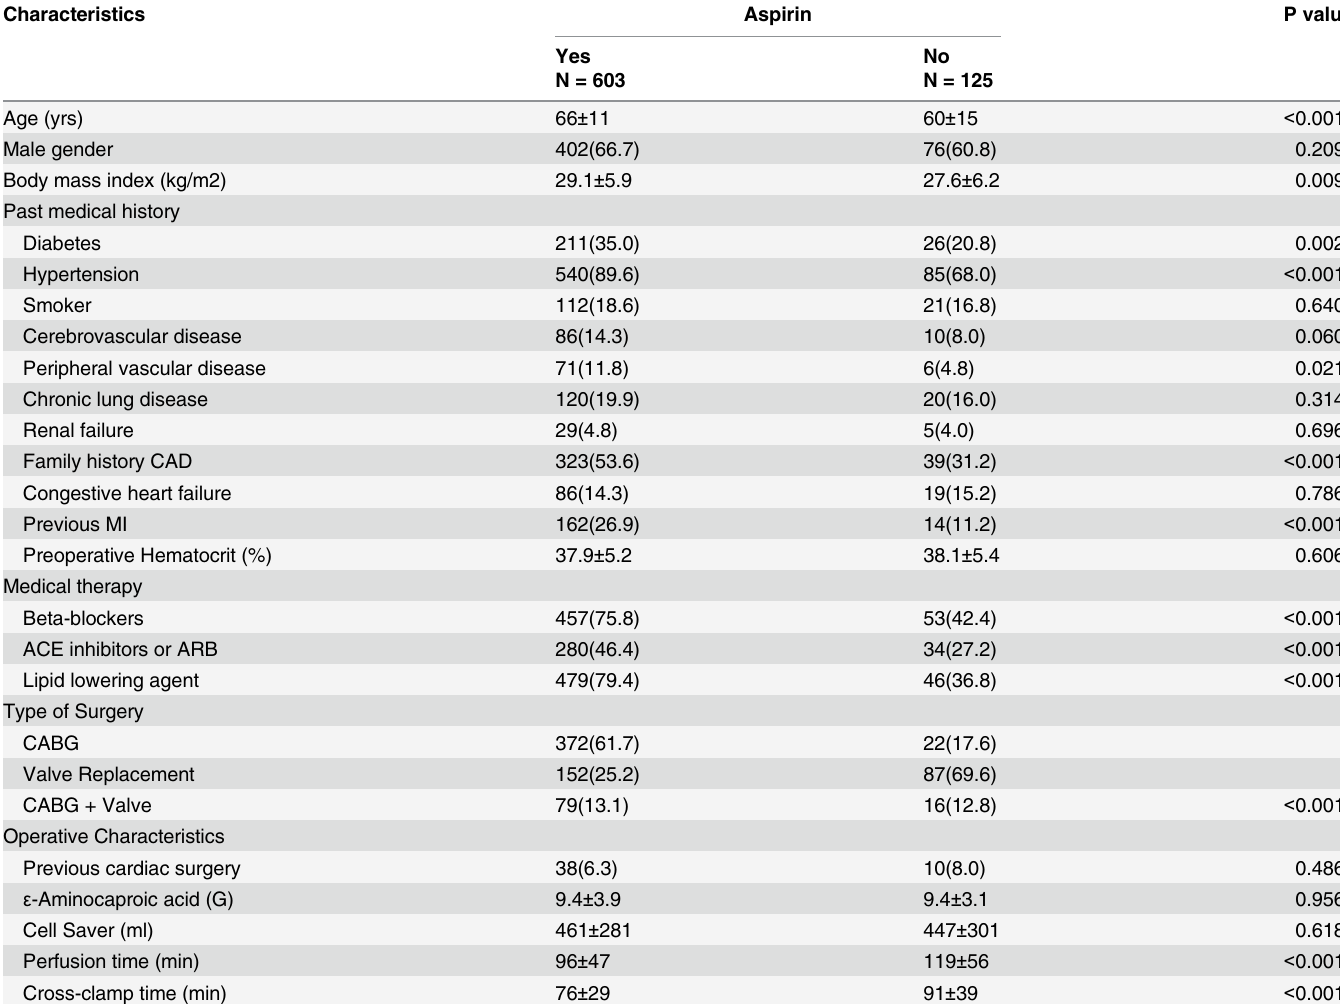
Table 1. Demographic and Clinical